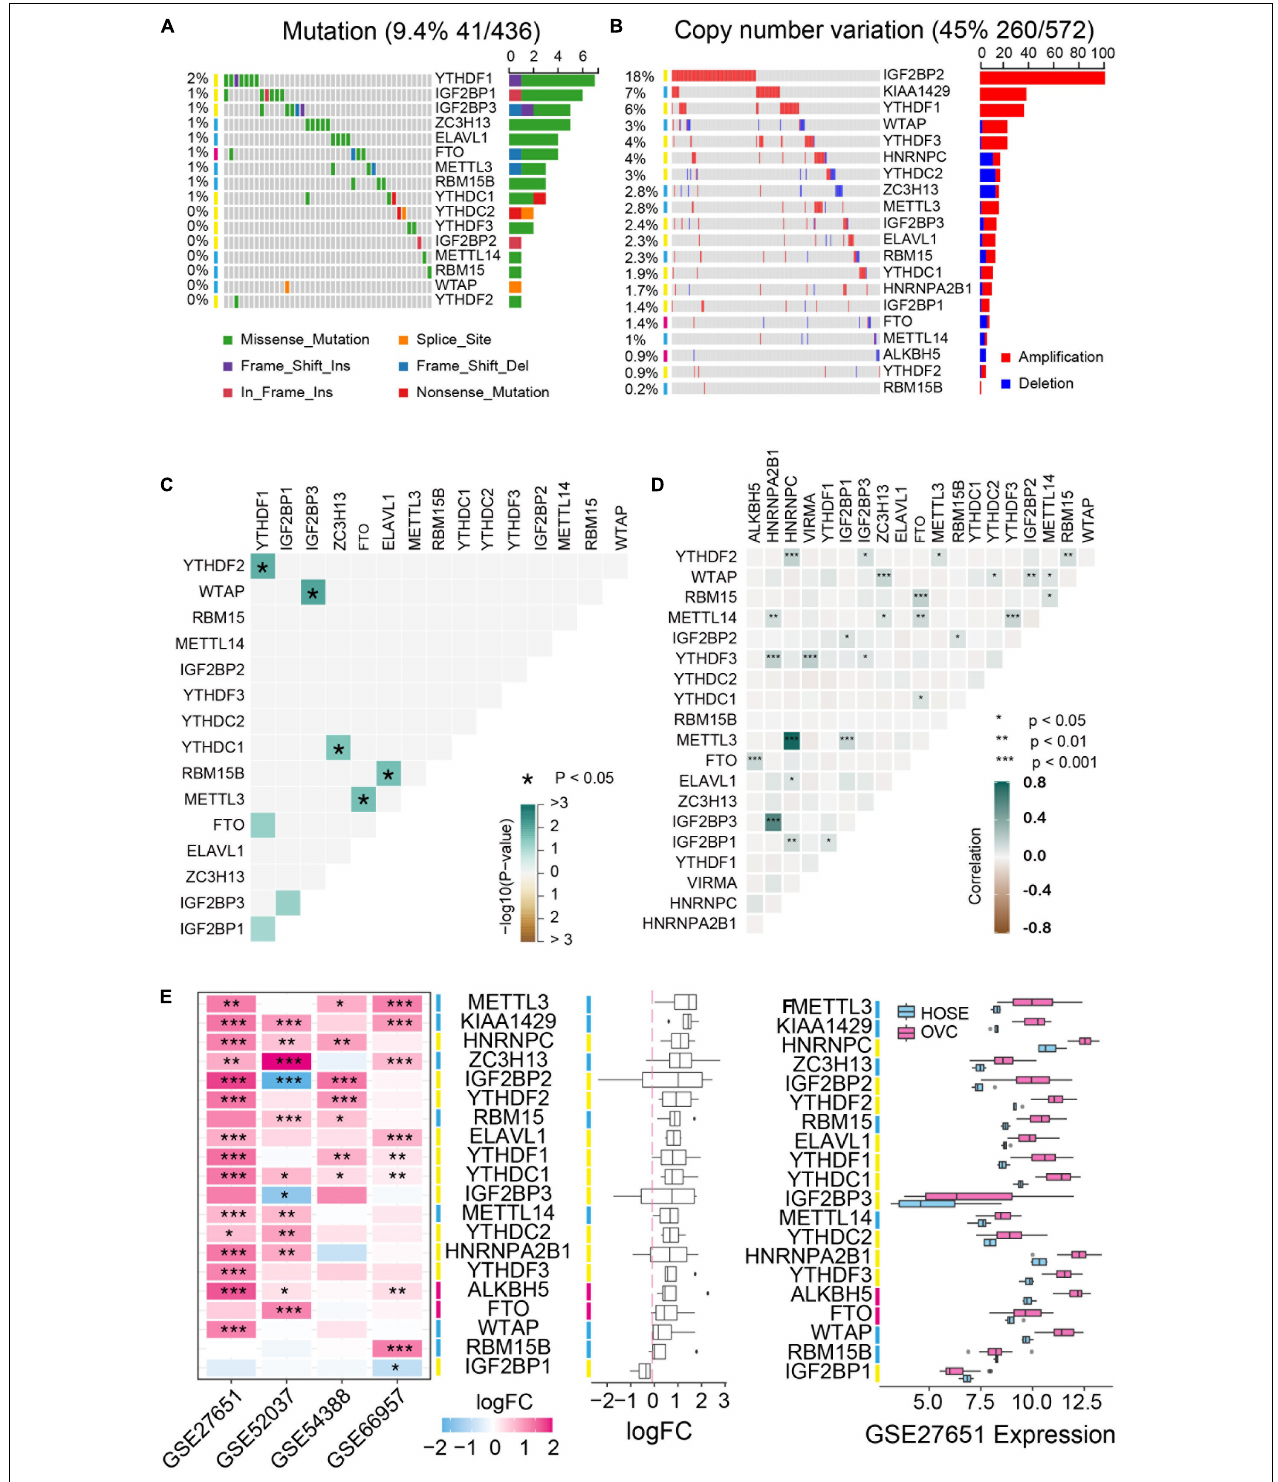
FIGURE 1 | Genetic variation and expression of m 6 A regulators in ovarian cancer. (A) The mutation frequency of m 6 A regulators in ovarian cancer available at TCGA database by using maftools package. (B) Copy number variations of m 6 A regulators in ovarian cancer available at TCGA database by using cBioPortal (http://cbioportal.org). (C) The mutation co-occurrence and exclusion analysis for m 6 A regulators. (D) The copy number variation co-occurrence and exclusion analysis for m 6 A regulators. (E) The mRNA expression alterations of m 6 A regulators in four independent GEO microarray datasets. (F) The mRNA expression of m 6 A regulators in GSE27651 cohort. HOSE, human ovarian surface epithelium, OVC, ovarian cancer. * P < 0.05, ** P < 0.01, *** P < 0.001.